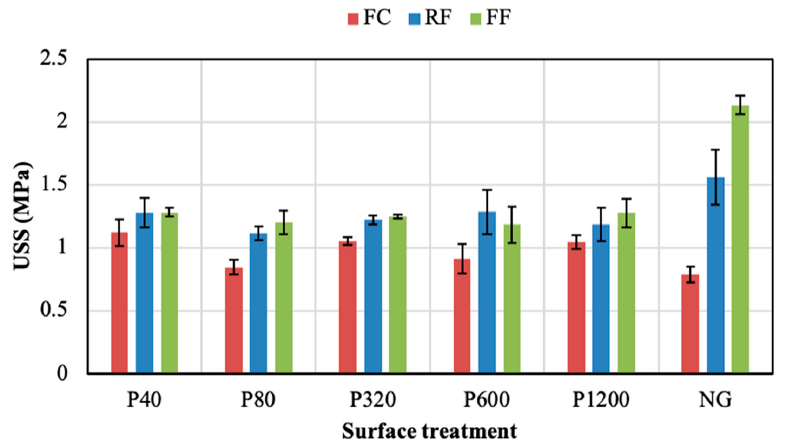
Figure 5. Ultimate shear strength (USS) of the adhesive joints under different surface treatments without adhesion promoter.